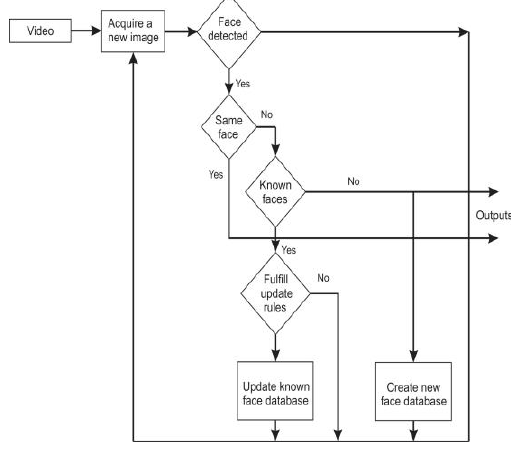
Figure 1. Phases in the process of face recognition There are two basic methods for face recognition.